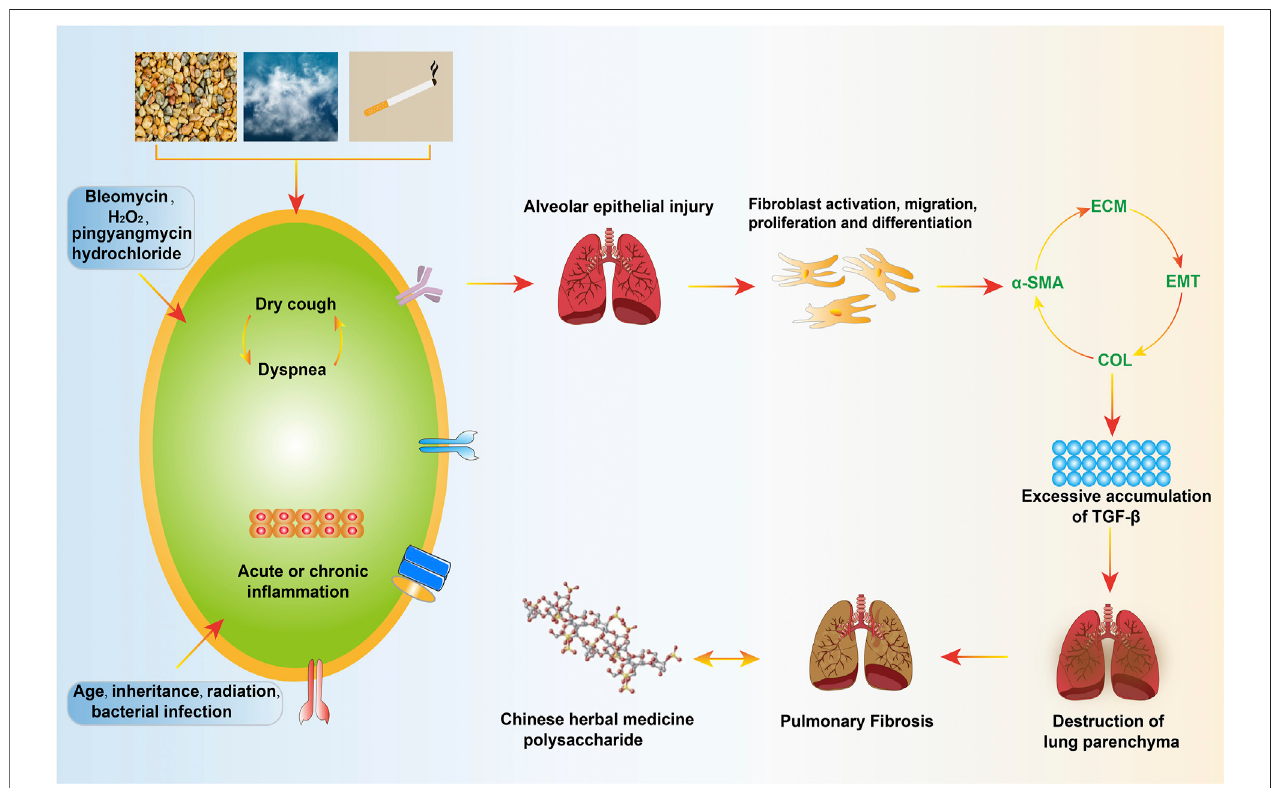
FIGURE 1 | Pathogenic factors and development process of pulmonary fi